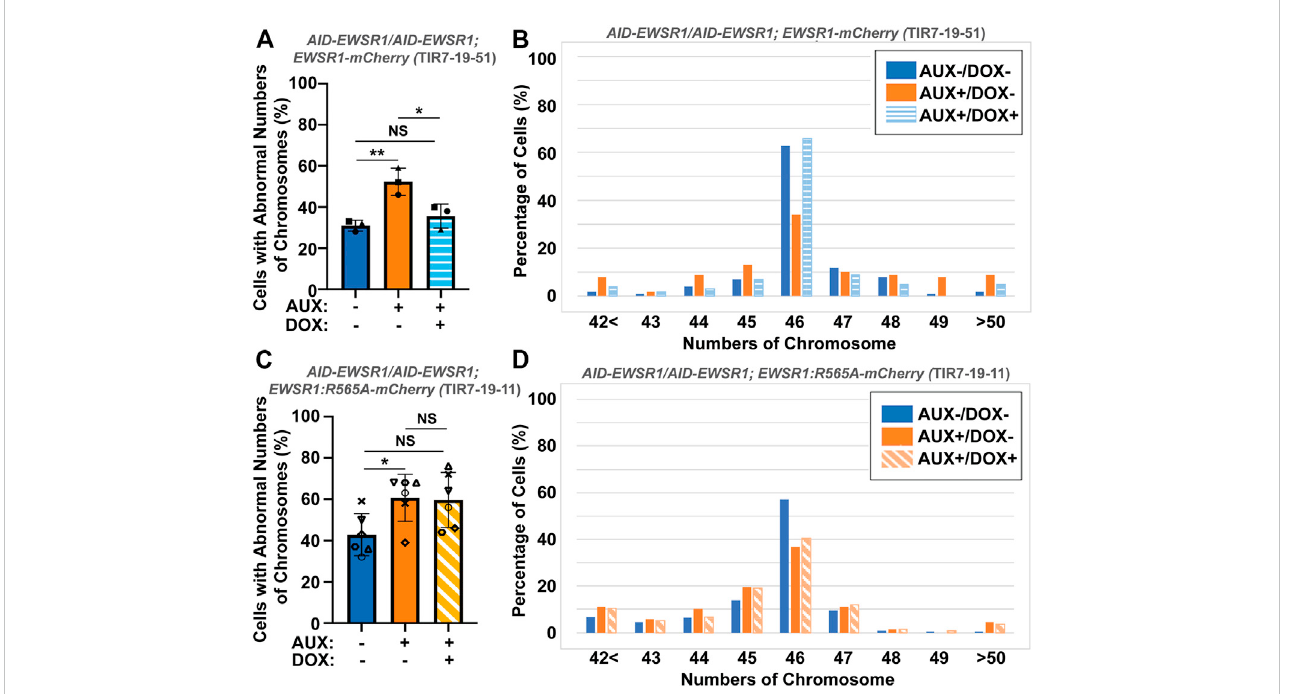
FIGURE 7 The interaction between EWSR1and AuroraBpreventstheinduction ofaneuploidy. (A) .The high incidence ofaberrant chromosomenumbers inAUX+/ DOX-treatedcellswasrescuedbytheexpressionofEWSR1overexpression(AUX+/DOX+)cells(28-59cellspersample, n =3experiments).One-wayANOVA with Tukey multiple comparison test., ** p < 0.01, * p < 0.05. NS = Non-signi fi cant. (B). The percentages of cells with each chromosome numbers in AUX-/ DOX- ( n = 122), AUX+/DOX- ( n = 117), and AUX+/DOX+( n = 106) cells. (C) . The high incidence of aberrant chromosome numbers in AUX+/DOX-cells was not rescued by the expression of EWSR1:R565A in AUX+/DOX + cells. (35-42 cells per sample, n = 6 experiments, One-way ANOVA with Tukey multiple comparisontest.* p < 0.05,NS=non-signi fi cant. (D) .ThepercentageofcellswitheachchromosomenumberinAUX-/DOX-( n =221),AUX+/DOX-( n =228), and AUX+/DOX+( n = 219)